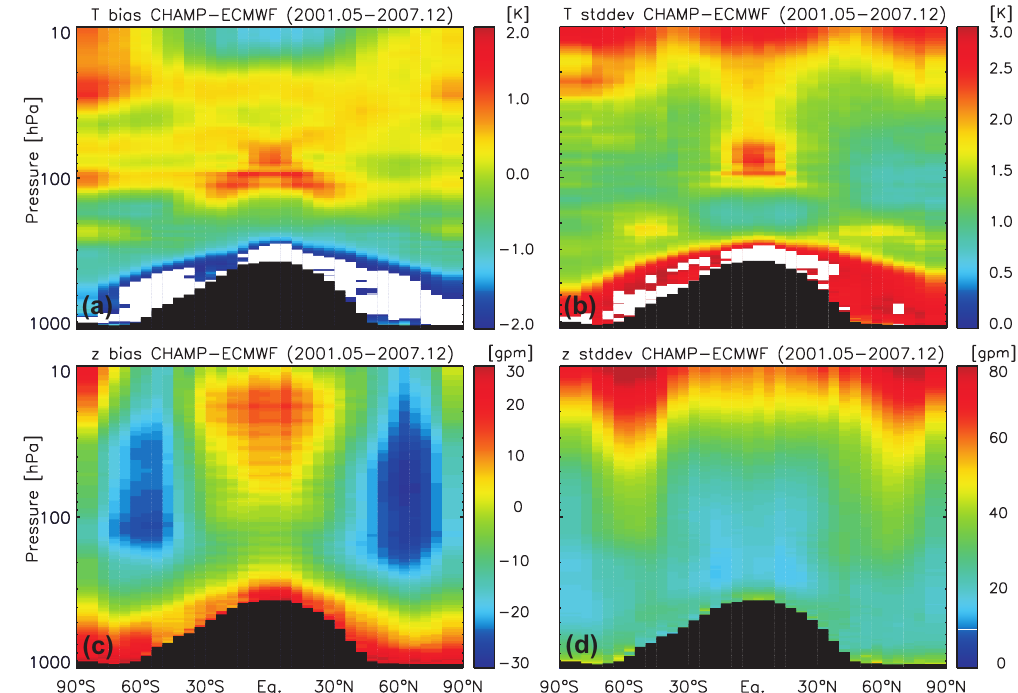
Fig. 2. Zonal mean temperature bias (a) , temperature stddev (b) , GPH bias (c) and GPH stddev between CHAMP and ECMWF for the pressure (altitude) range 1000–10hPa and the time interval May 2001–December 2007. The meridional resolution is 5 ◦ between 77.5 ◦ N– 77.5 ◦ S and 10 ◦ for 85 ◦ N and 85 ◦ S. The vertical pressure resolution corresponds to an altitude resolution of about 200–300m. The black areas denote regions with temperatures above 250K. In the white areas the bias is less than − 2K (a) and the stddev is larger than 3K